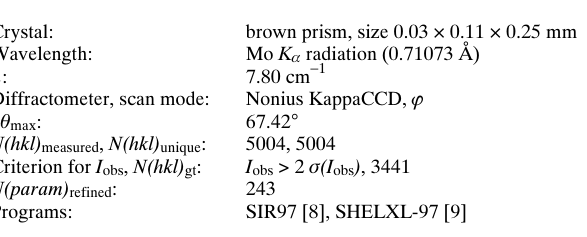
Table 1. Datacollection and handling.